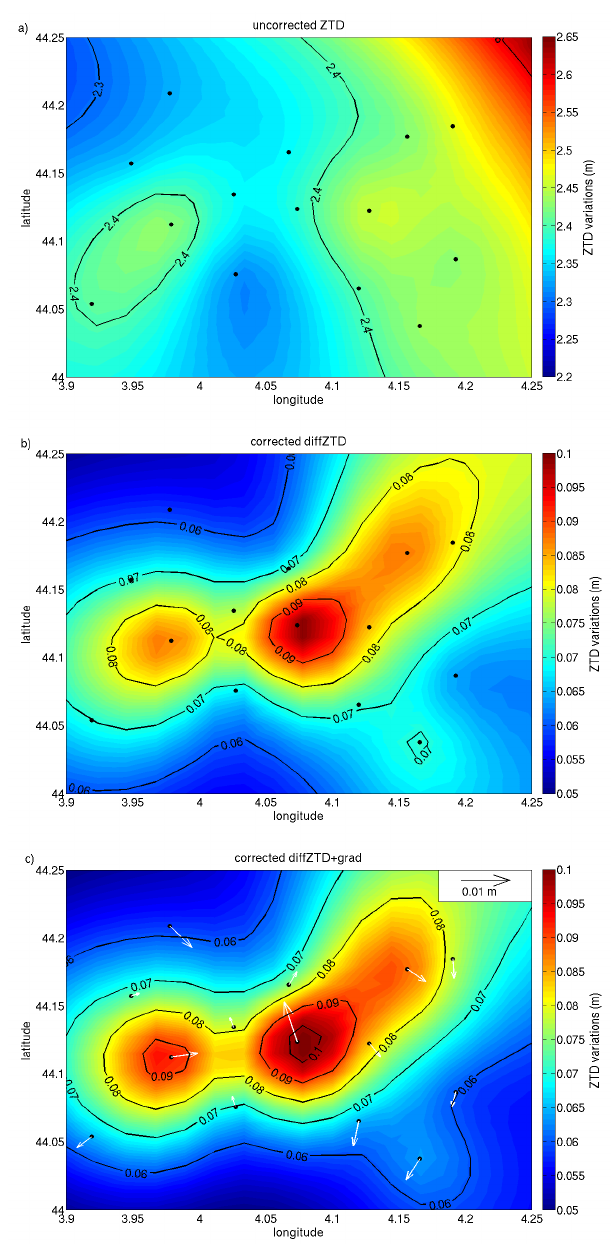
Fig. 12. Instantaneous 2-D field of zenith delay variation (21 Octo- Figure 12: Instantaneous 2D field of zenith delay variation (October 21th, 2002, at 19H15 UTC), 2 ber 2002, at 19:15UTC), interpolated from measurements at GPS interpolated from measurements at GPS station locations uncorrected (a) and topography-corrected (b 3 station locations uncorrected (a) and topography-corrected ( b and C ) for station altitude by subtracting the average ZTD over the two and c) for station altitude by subtracting the average ZTD over the two months measurement campaign. 4 months measurement campaign. The ZTD field (b) is established The ZTD field (b) is established without and (c) with integrating horizontal delay gradients. Site locations 5 without and (c) with integrating horizontal delay gradients. Site lo- cations are indicated by stars, vectors correspond to horizontal gra- are indicated by stars, vectors correspond to horizontal gradients (scale vector corresponds to 0.01 m). 6 dients (scale vector corresponds to 0.01m). The colour code indi- The colour code indicates ZTD variations in m. 7 cates ZTD variations in m.